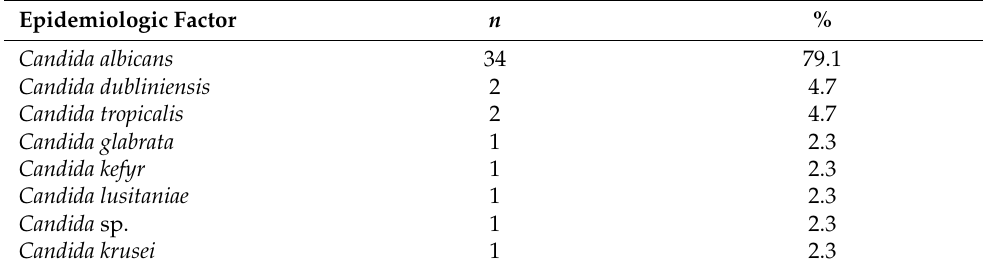
Table 4. Epidemiological factors of pneumonia in the studied group based on the inoculation from the respiratory tract secretion—yeast-like fungi.